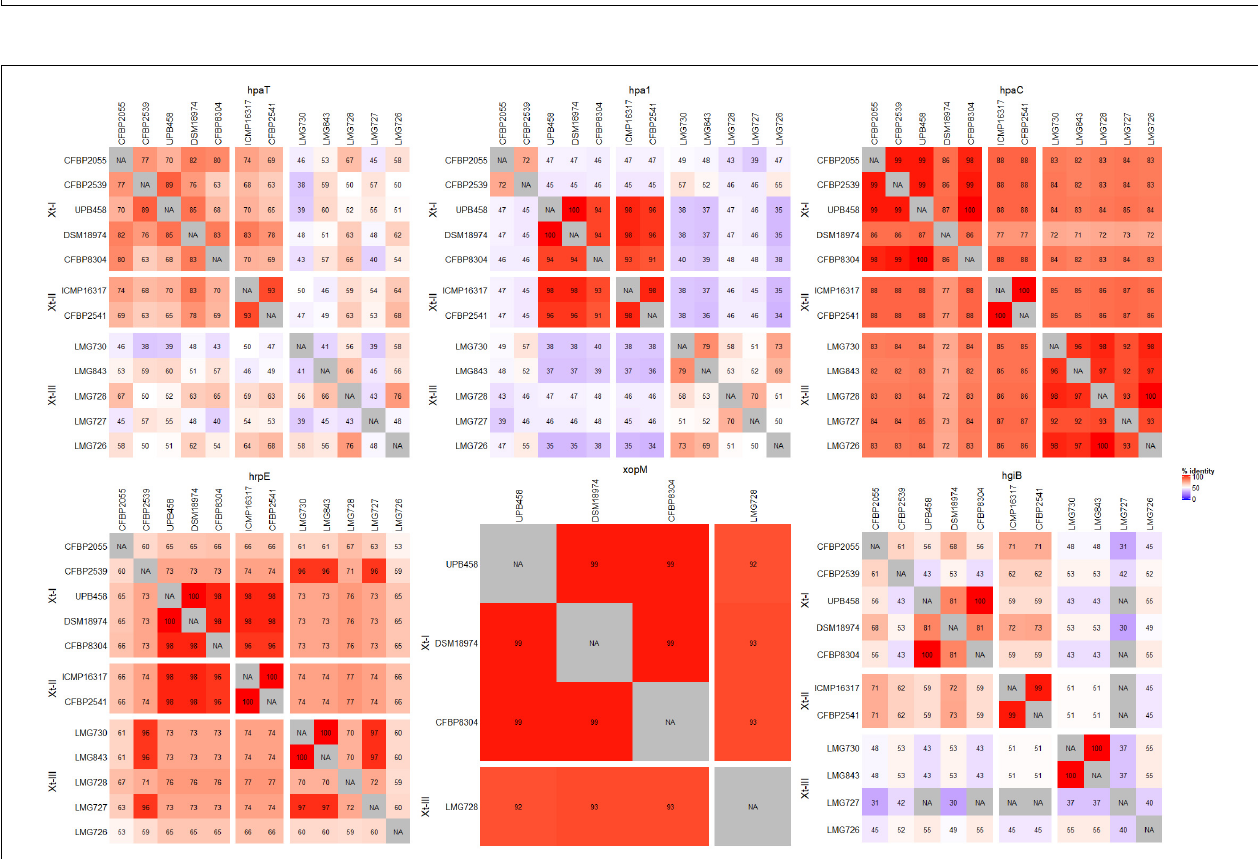
FIGURE 6 | Pairwise comparisons of the nucleotide sequences of the most variable components of the type III secretion system across all X. translucens pathotype strains. For xopM , only UPB458, DSM 18974, CFBP 8304, and LMG 728 were considered, as they were the only strains where a complete gene was identified.